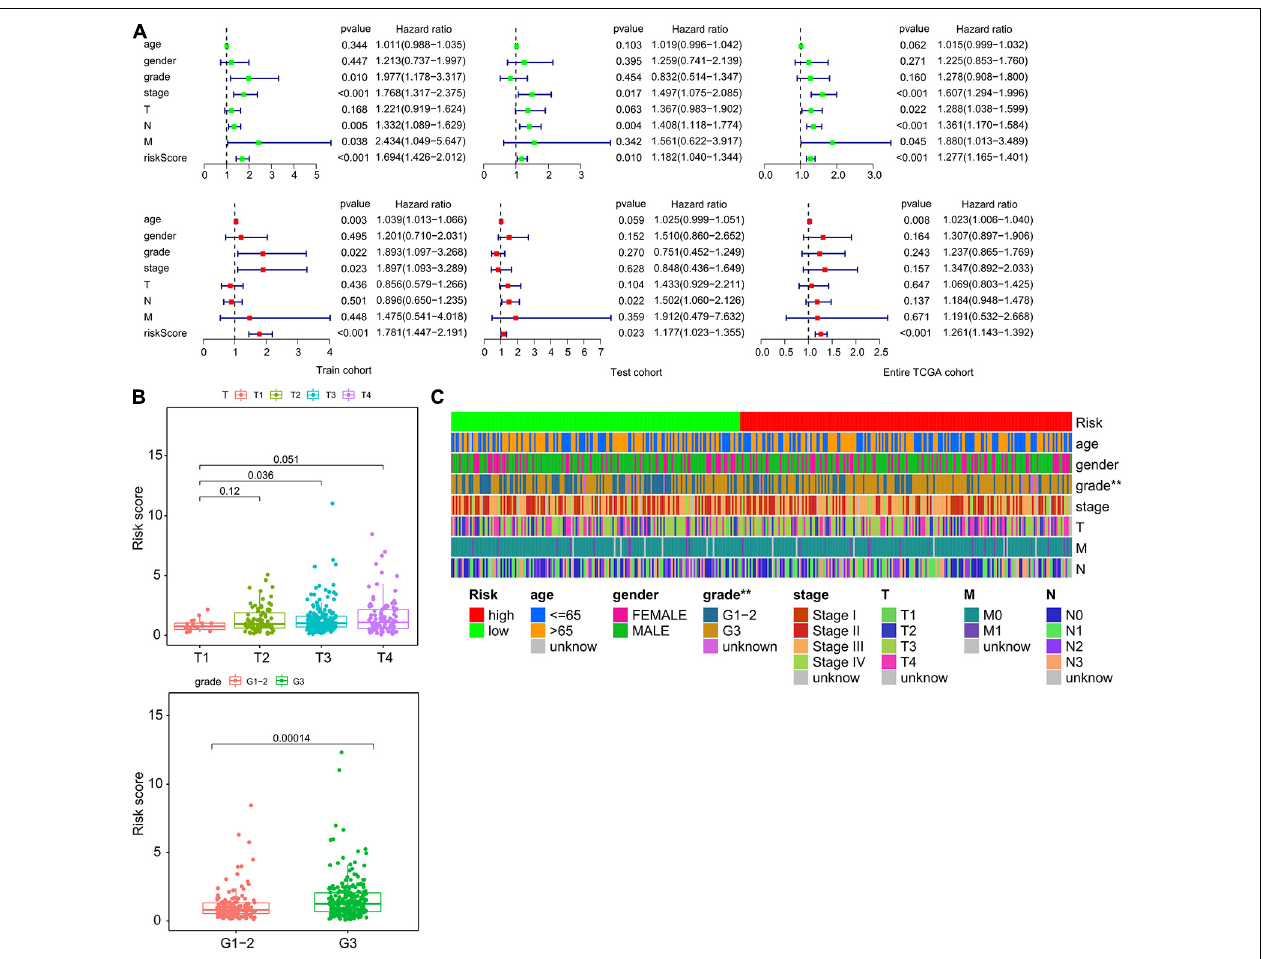
FIGURE 3 | Independence of ImmiRSig from molecular features and other clinical variables. (A) Univariate and multivariate Cox analyses of ImmiRSig with other clinical variables. (B) Boxplot showing distribution of the ImmiRSig in patients with different stage and grade. (C) Distribution of molecular features and other clinical variables in the low-risk and high-risk